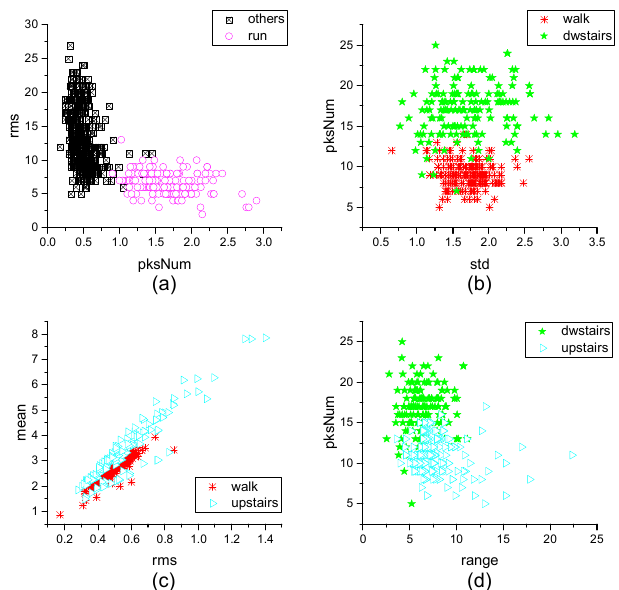
Figure 17. The results of each sub-classifier. ( a ) run and other actions with the features rms and pksNum ; ( b ) walk and dwstairs with the features std and pksNum ; ( c ) walk and upstairs with the features rms and mean ; ( d ) dwstairs and upstairs with the features range and pksNum . Table 8. Performance of each sub-classifier.